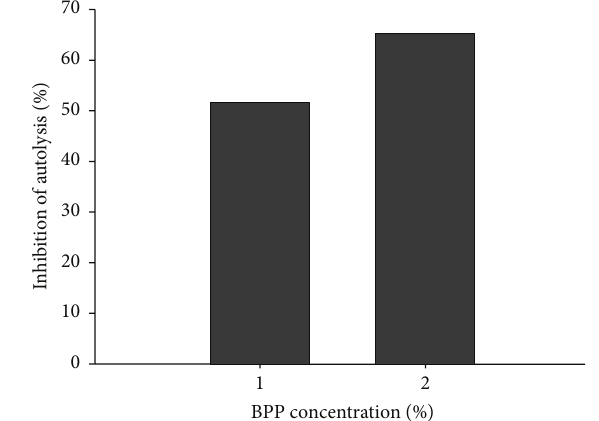
Figure 2: Effect of addition of BPP on the inhibition of the autolytic activity of sols from giant squid ( Dosidicus gigas ).